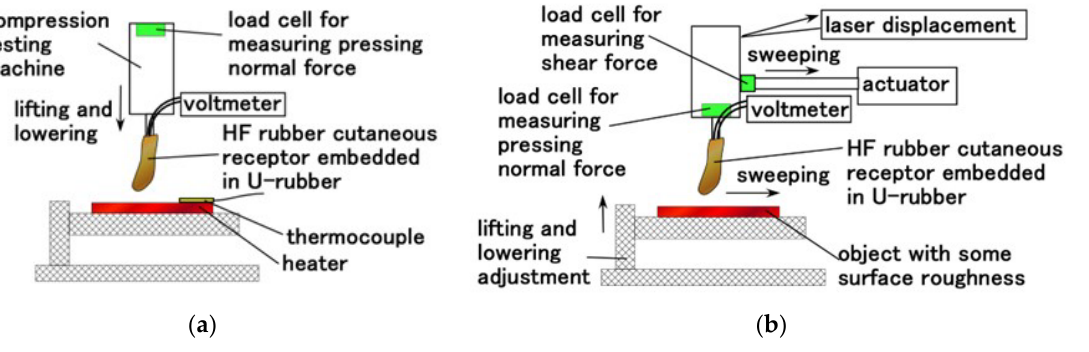
Figure 7. Schematic diagram of the experimental apparatus for measuring tactile and thermal senses: ( a ) applying a normal force (NFE) and ( b ) applying a shear force (SFE).